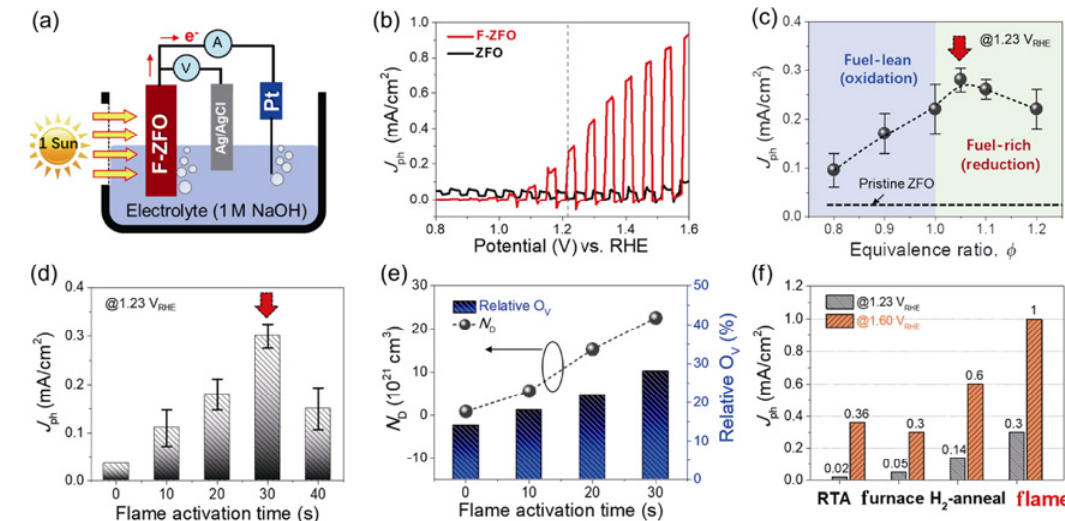
Fig. 3 Photoelectrochemical (PEC) activity. (a) Schematic of PEC cell. (b) Representative photocurrent density–potential ( J – V ) curves of ZFO and F-ZFO measured under simulated sunlight illumination (100 mW/cm 2 ). (c) Effects of the flame equivalence ratio on the photocurrent density ( J ph values are extracted at 1.23 V RHE from corresponding J – V curves). (d) Effects of the flame activation time on the J ph . (e) Variations of donor concentration ( N D ) and oxygen vacancy amount (O V ) as a function of the flame activation time. (f) Comparison of various activation methods. Flame-activated ZFO shows the highest J ph , indicating the effectiveness of flame activation in improving the PEC activity of